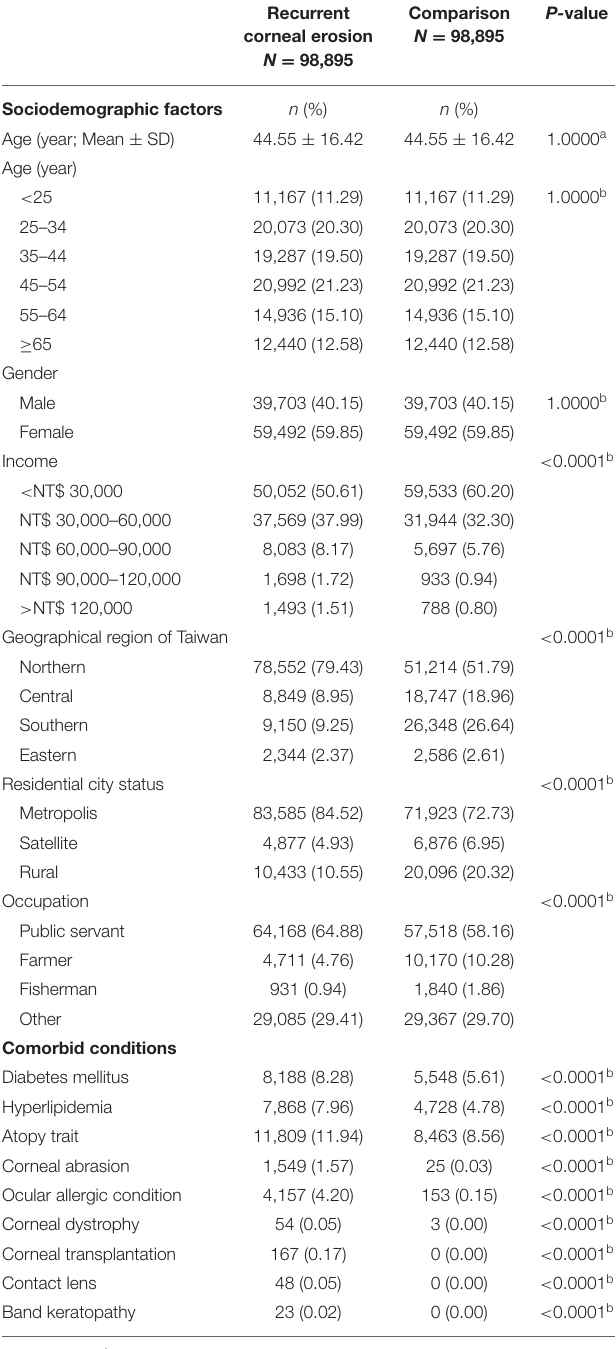
TABLE 1 | Baseline sociodemographic factors and comorbid conditions of recurrent corneal erosion patients and control subjects after matching by age and